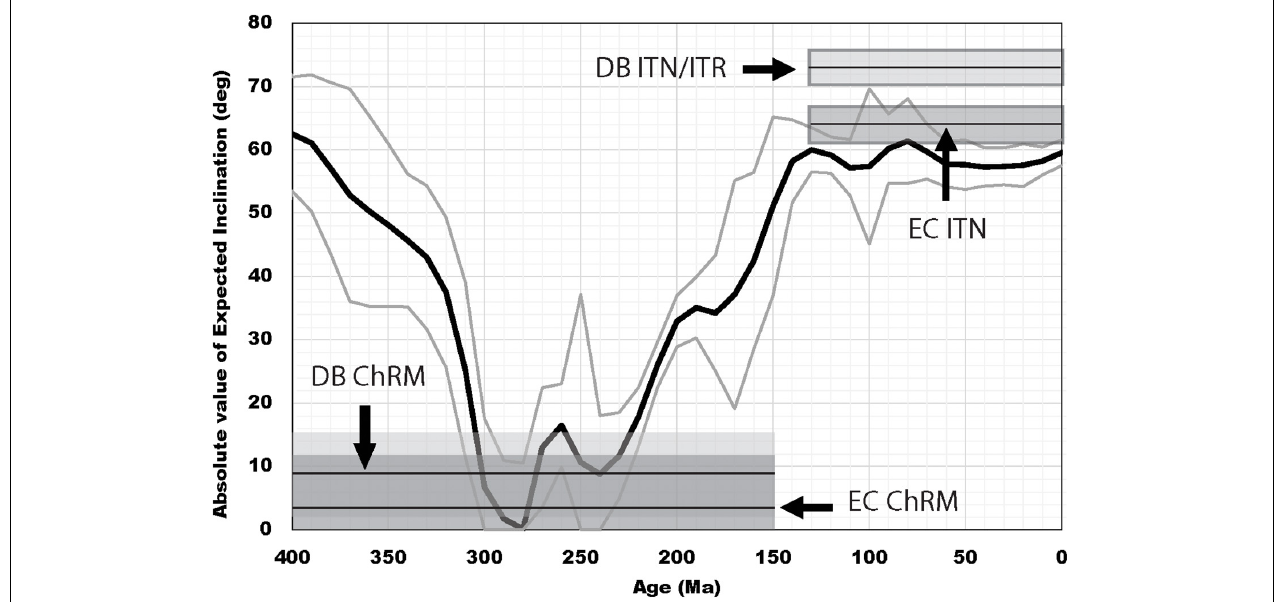
FIGURE 6 | Expected Inclination plot (absolute values of inclinations calculated from Torsvik et al., 2012) with the ChRMs and ITN/ITR mean inclinations for both cores. The thick line represents the expected inclination in Bradford County and the gray lines represent α 95 values for the expected inclinations. The labeled arrows point to the mean inclinations for each component and the shaded areas are the age ranges errors for the components based on the α 95 values.